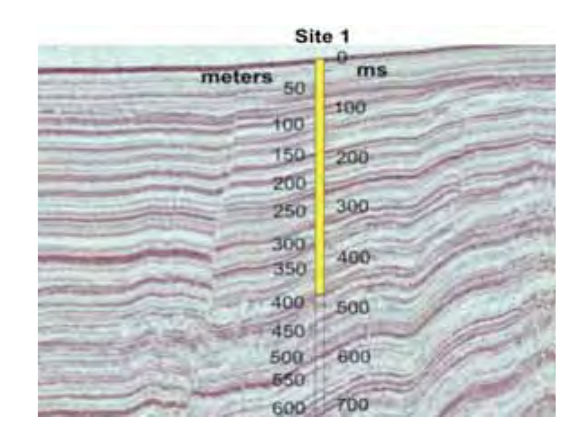
Figure 1. Bathymetry of the Lake Malawi Rift, with drill site locations and seismic pro fi les. Figure 2. Airgun seismic pro fi le with penetration at Site